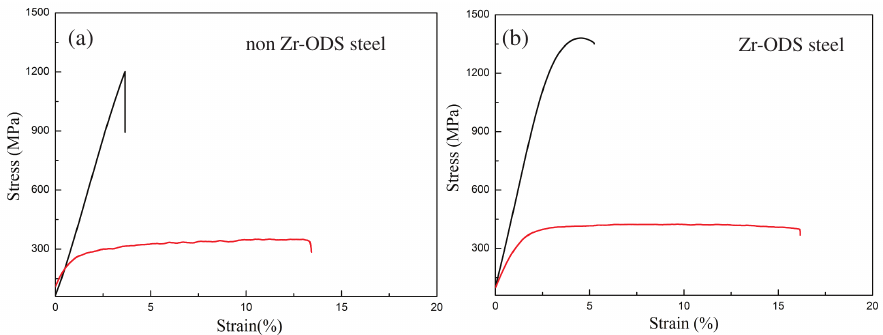
Figure 7: Tensile stress – strain curves of 15Cr-ODS steels at RT and 650°C (a) non Zr-ODS steel (b) Zr-ODS steel.